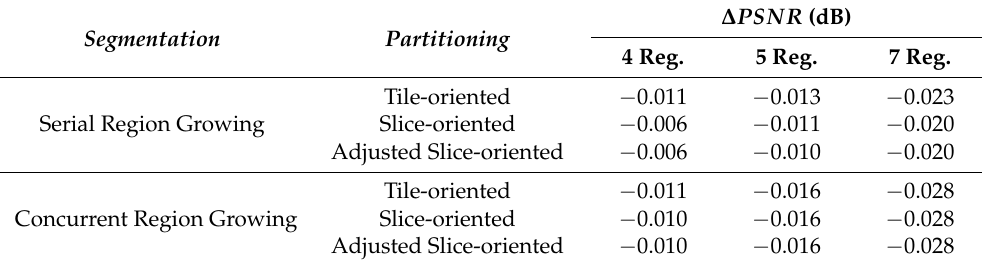
Table 7. PSNR (dB) difference between proposed algorithm and baseline VVC encoder.